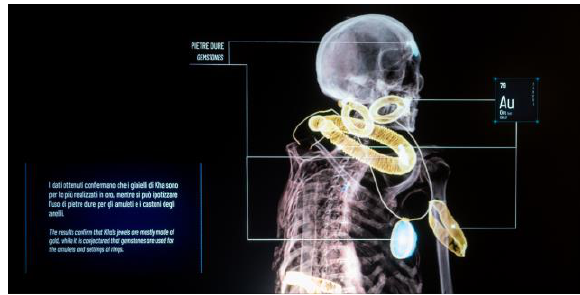
Figure 2. Virtual unwrapping of the mummy of Kha (Eighteenth Dynasty), from the exhibition Archeologia Invisibile, Museo Egizio, Torino, 2019 (photograph by Museo Egizio, Torino).